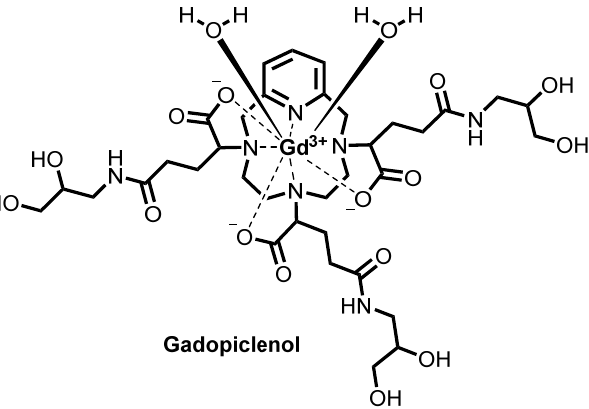
Figure 2. FDA-approved GBCAs utilized in the clinical practice.